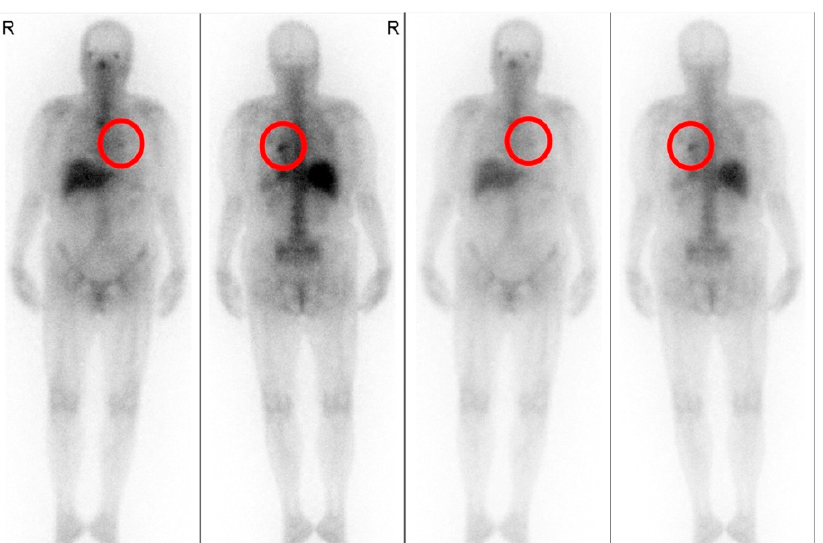
Figure 2. Gallium scintigraphy showing abnormal accumulation of gallium (red circle), consistent with the infiltrating shadow and gas image of the lung fields seen on contrast CT. CT, computed tomography.